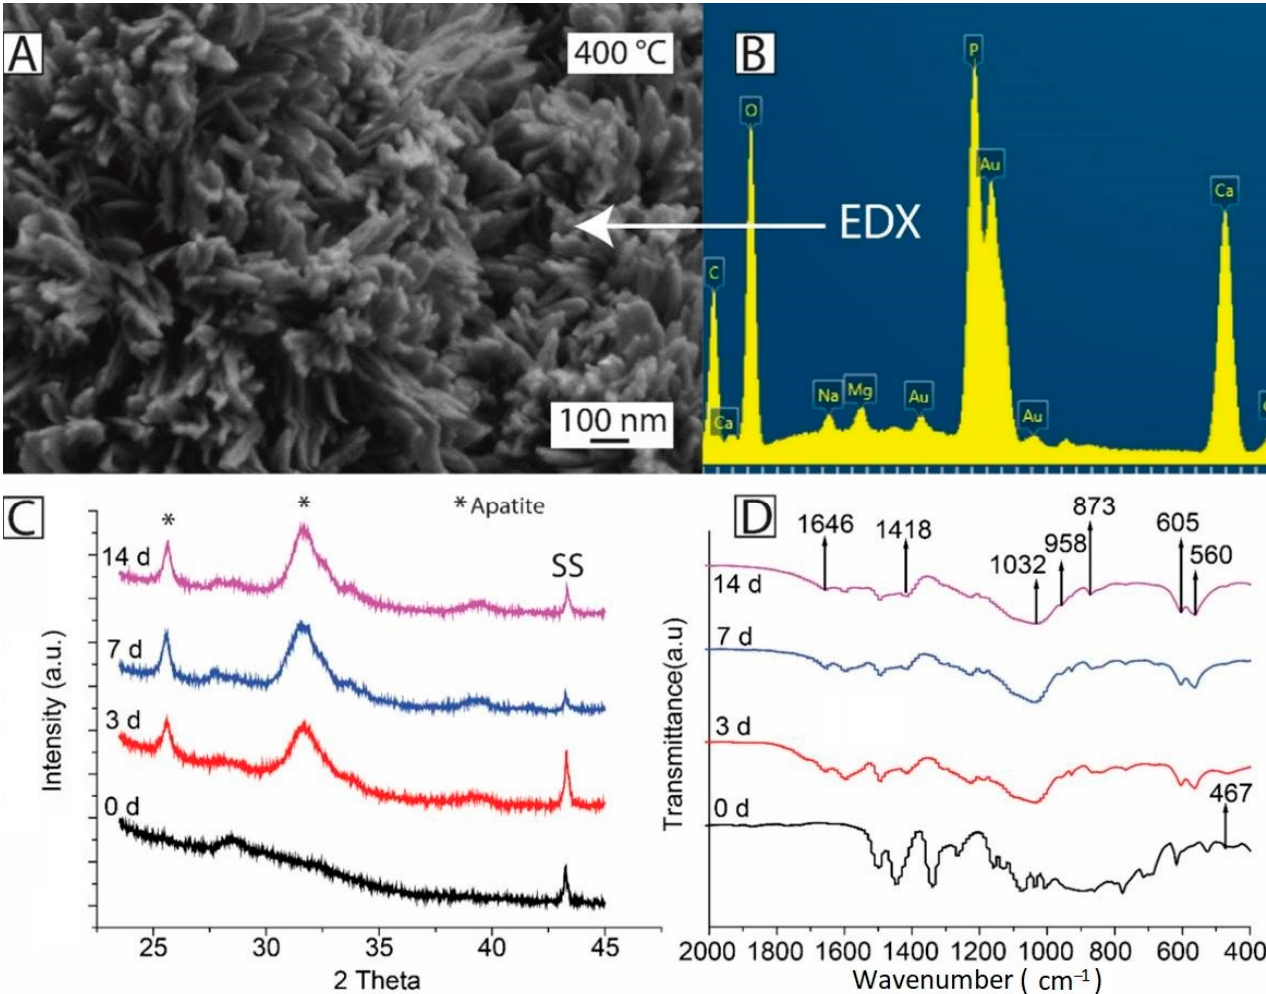
Figure 24. PEEK/BG coatings sintered at 400 °C: ( A ) SEM image after treatment in SBF for 7 days; ( B ) EDX analysis after treatment in SBF for 7 day; ( C ) XRD patterns before and after treatment in SBF for 3, 7, and 14 days; and ( D ) FTIR spectra before and after treatment in SBF for 3, 7, and 14 days. Reproduced from [107].